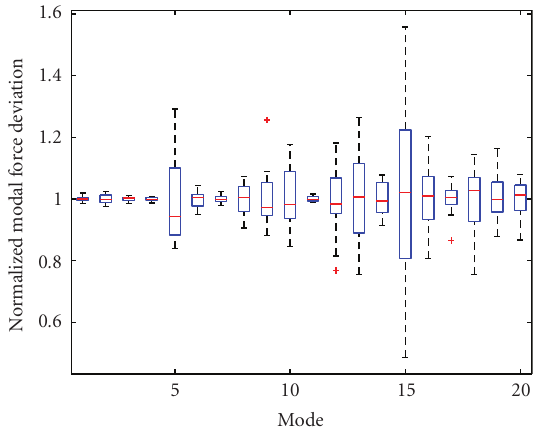
Figure 8: Airfoil modal force variation.